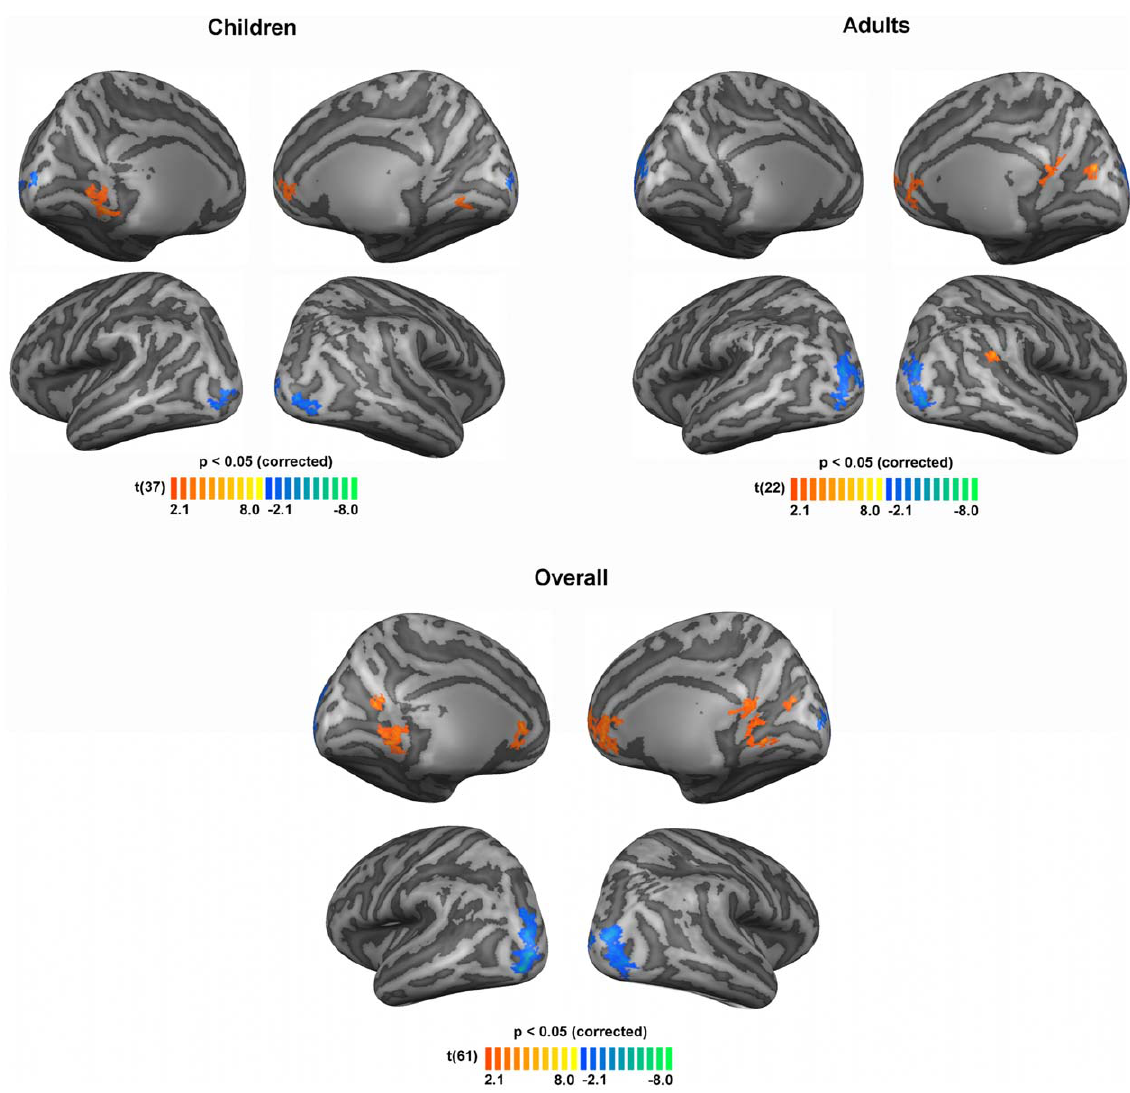
Figure 2. Significant differences in brain activations between patients with NF1 and controls, regarding the M-biased stimulus for children, adults and overall (children and adults) groups. Blue colours depict regions where activation was lower for individuals with NF1 than controls. Orange colours depict regions where activation was higher for individuals with NF1 than controls. Results are shown on views of the left and right hemispheres of cortex-based aligned three-dimensional reconstructions generated from the average anatomical data sets of the subjects in each group (children, adults, overall). Light grey represents gyri, dark grey represents sulci. T-maps thresholded at p , 0.05 corrected using cortex-based cluster threshold estimation (cluster size 41 mm 2 ). N=15 children with NF1, 24 control children, 13 adults with NF1 and 11 control adults.